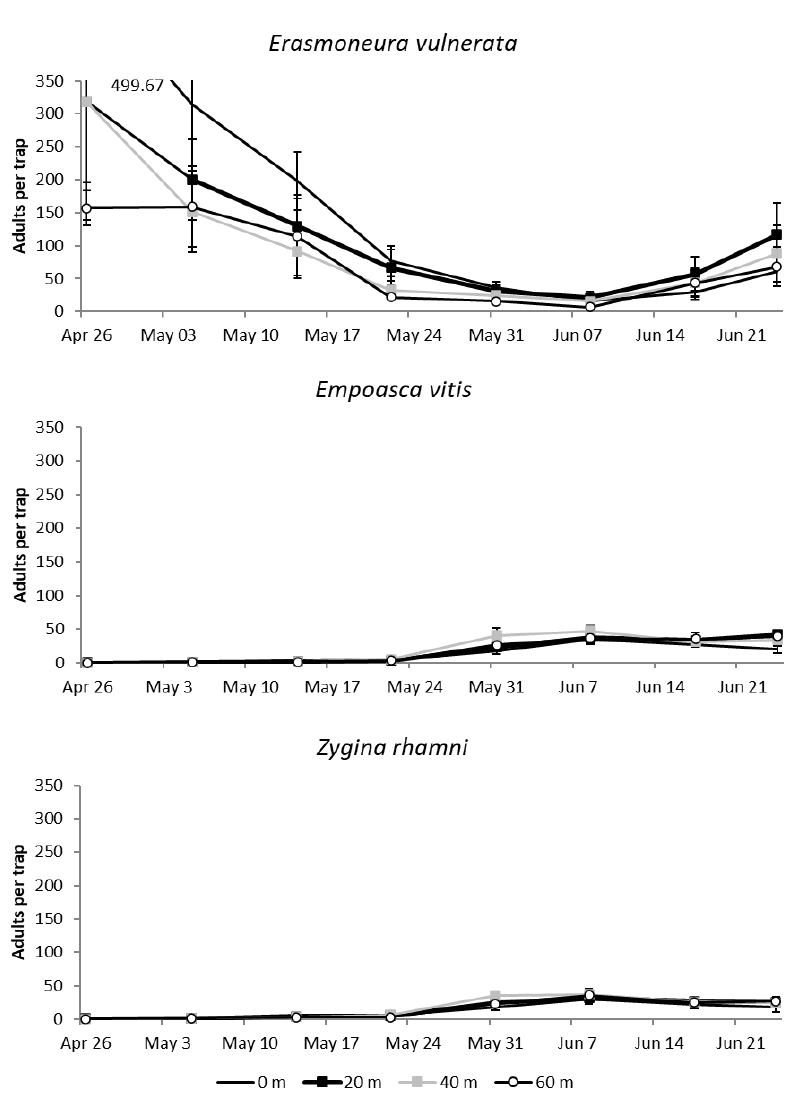
Figure 2. Mean ( ± std. err.) number of adult E. vulnerata , E. vitis and Z. rhamni catches on traps placed at increasing distances from the vineyard margins in the spring of 2017.